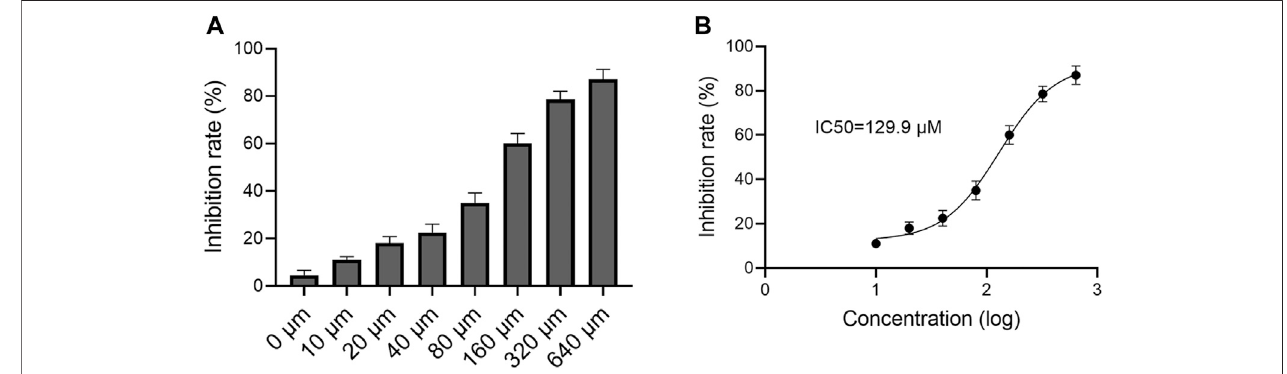
FIGURE 2 | Effect of reynoutrin on H9c2 cells viability. MTT was used to detect the cytotoxicity of reynoutrin on H9c2 cells. (A) The inhibition rate of different concentrations of reynoutrin on H9c2 cells for 24 h (B) Logarithmic function dose-effect curve of reynoutrin on H9c2 cells. The values were presented as the means ± standard error for six independent experiments